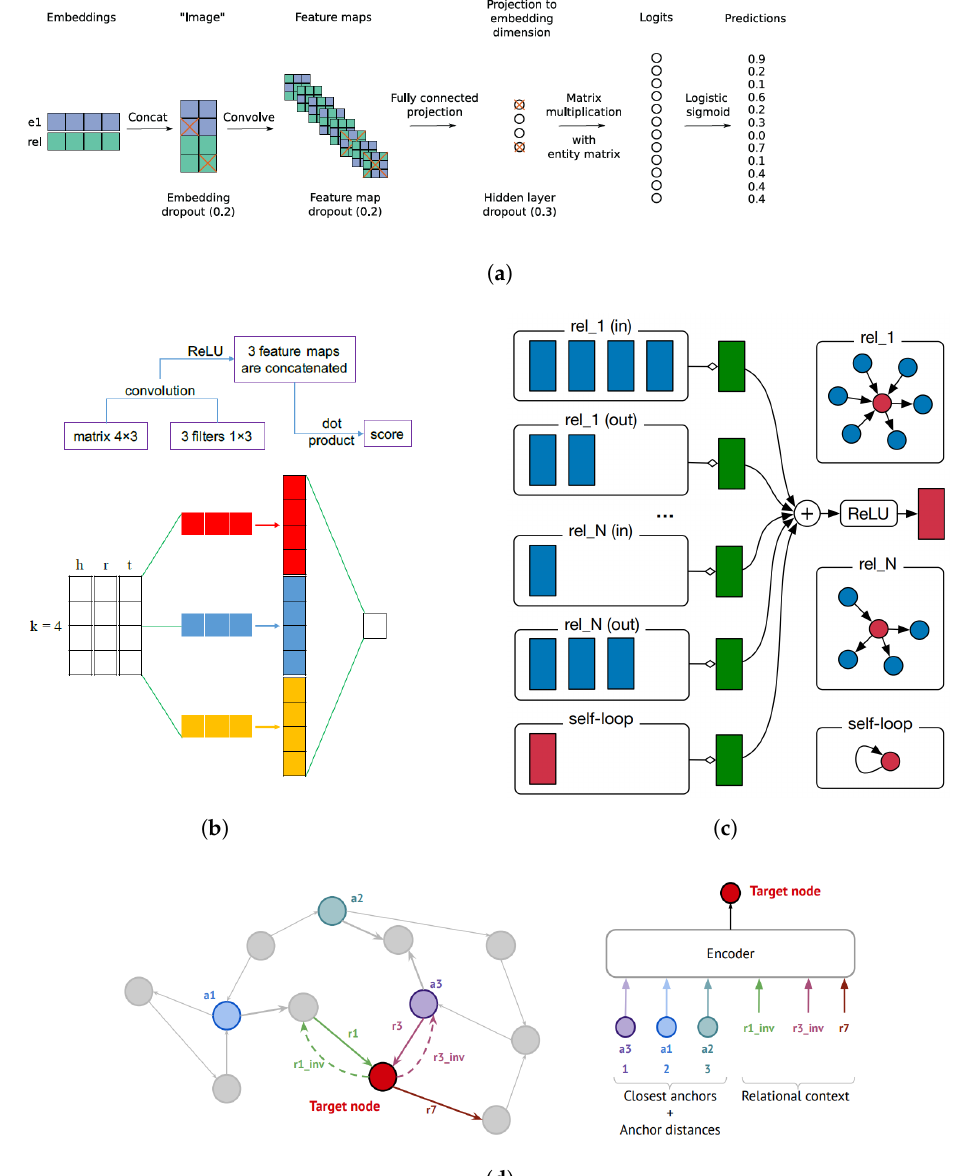
Figure 6. Illustration of neural network-based models. ( a ) In the ConvE model, the entity and relation embeddings are first remodeled in a 2D embedding and then concatenated (steps 1 and 2). The resulting matrix goes through a 2D convolution layer (step 3). Then, the feature map tensor is vectorized and projected into a k-dimensional space (step 4) and matched with all candidate tail-entity embedding t through an inner product (step 5). Taken from [35]. ( b ) The process involved in ConvKB with the embedding size d = 4, set of three filters Ω (for illustration purposes), and the activation function σ = ReLU. Taken from [36]. ( c ) Diagram showing the update of a single event-graph node (red) in the R-GCN model. Activations from neighboring nodes (dark blue) are gathered and then transformed for each relation type individually. The resulting representation (green) is accumulated in a (normalized) sum and passed through an activation function. Taken from [37]. ( d ) NodePiece tokenization strategy. Given three anchors a 1, a 2, a 3, a target node can be tokenized into a hash of top-k closest anchors, their distances to the target node, and the relational context of outgoing relations from the target node. This hash sequence is passed through an injective encoder to obtain a unique embedding. Taken from